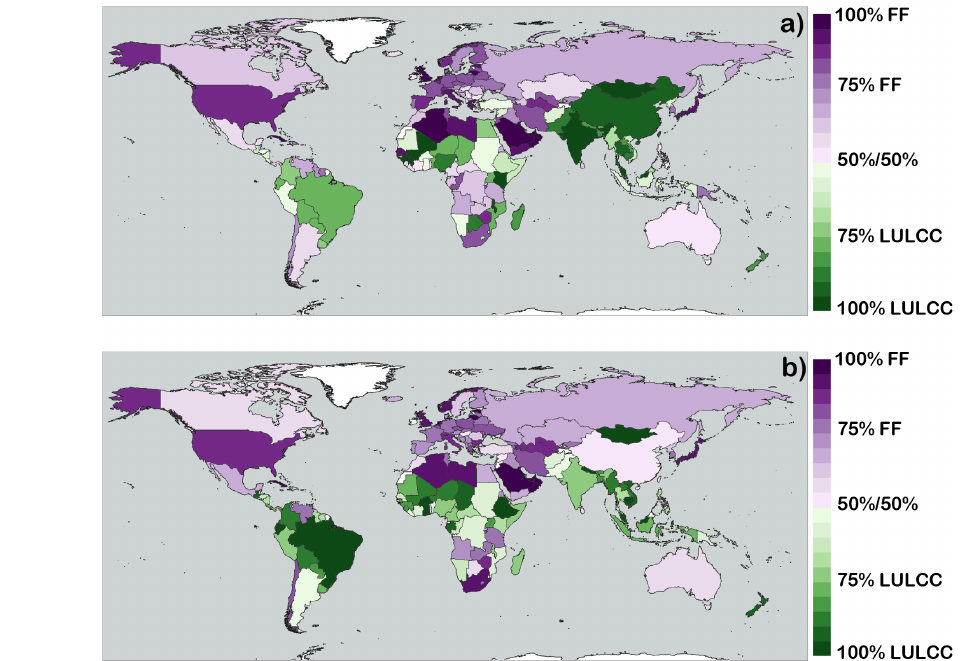
Figure 7. The ratio of the absolute value of LULCC RF to the absolute value of the RF of fossil fuel burning activities computed for each country for the year 2010 including (a) all forcing agents, and (b) only greenhouse gas forcing agents.